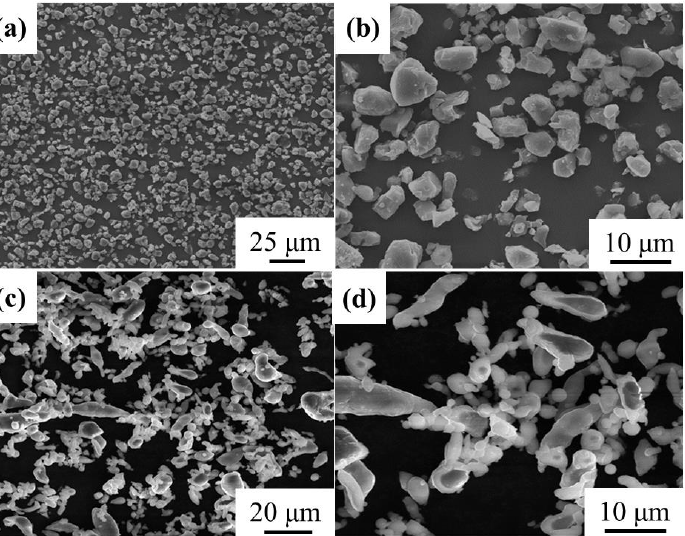
Figure 1. The morphology of AlN and Al powders. ( a ) Low and ( b ) high magnification of AlN powders; ( c ) Low and ( d ) high magnification of Al powders.